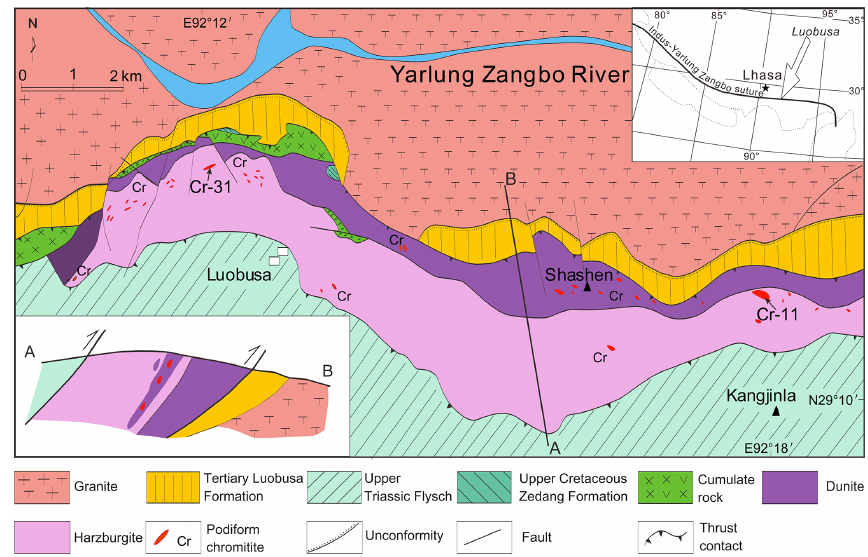
Figure 1. Map and cross section of the Luobusa ophiolite, Tibet, showing podiform chromitite orebodies in the vicinity of Luobusa and Kangjinla. The ophiolite has been overturned. Minerals separated from the orebody Cr-11 are the focus of the present